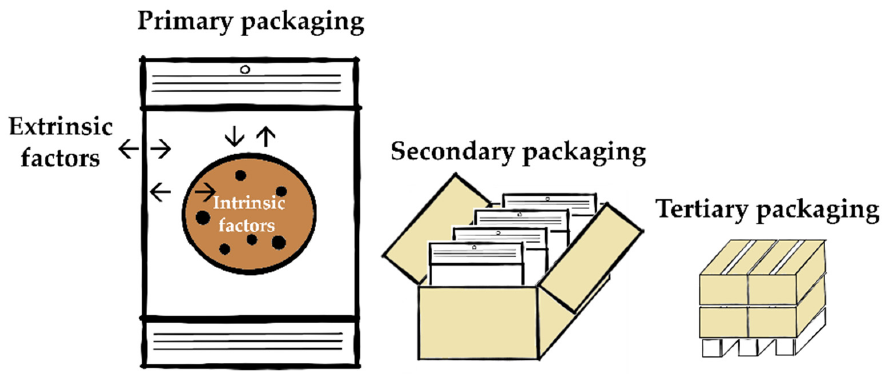
Figure 2. Schematic packaging levels of fine bakery ware (example: chocolate chip cookie), adapted from [12,13,31] .